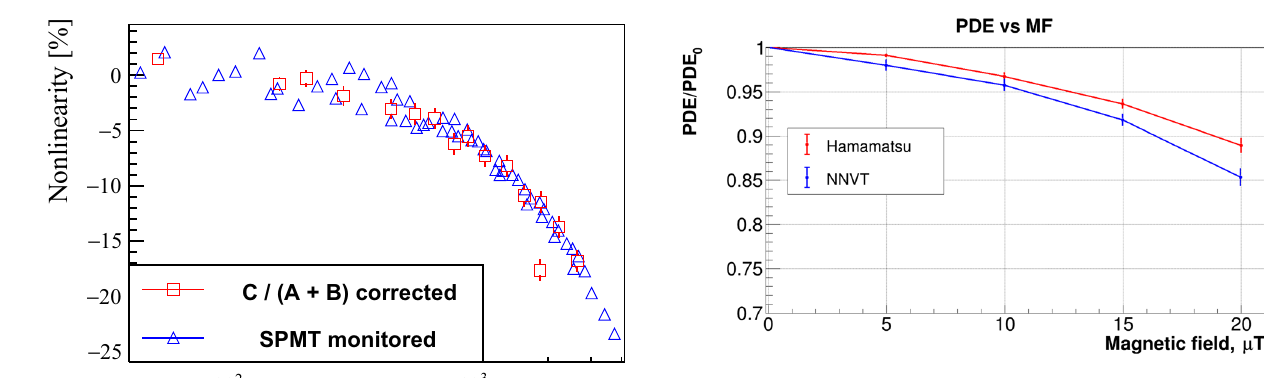
Fig. 32 Averaged PMT PDE versus remaining magnetic field (MF) strength tested with 9 HPK and 15 NNVT